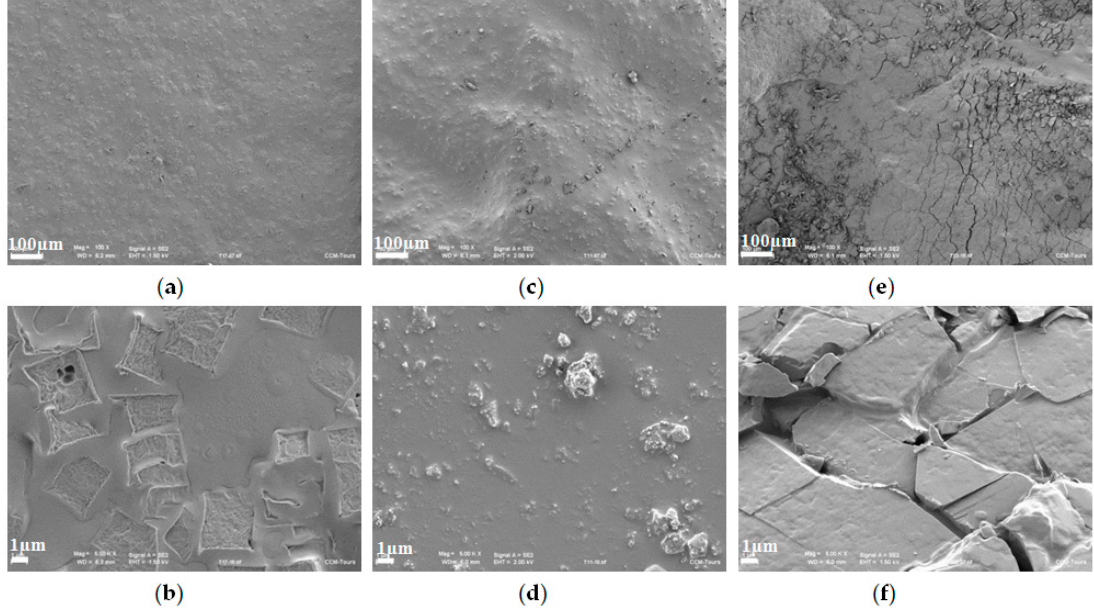
Figure 2. Scanning electron microscopy (SEM) micrographs of POSS nanocomposites. ( a , b ) F TA ‐ 20 ; ( c ) and ( d ) F TP ‐ 20 ; ( e , f ) F TF ‐ 20 (POSS content 20 phr). ( c , d ) F TP-20 ; ( e , f ) F TF-20 (POSS content 20